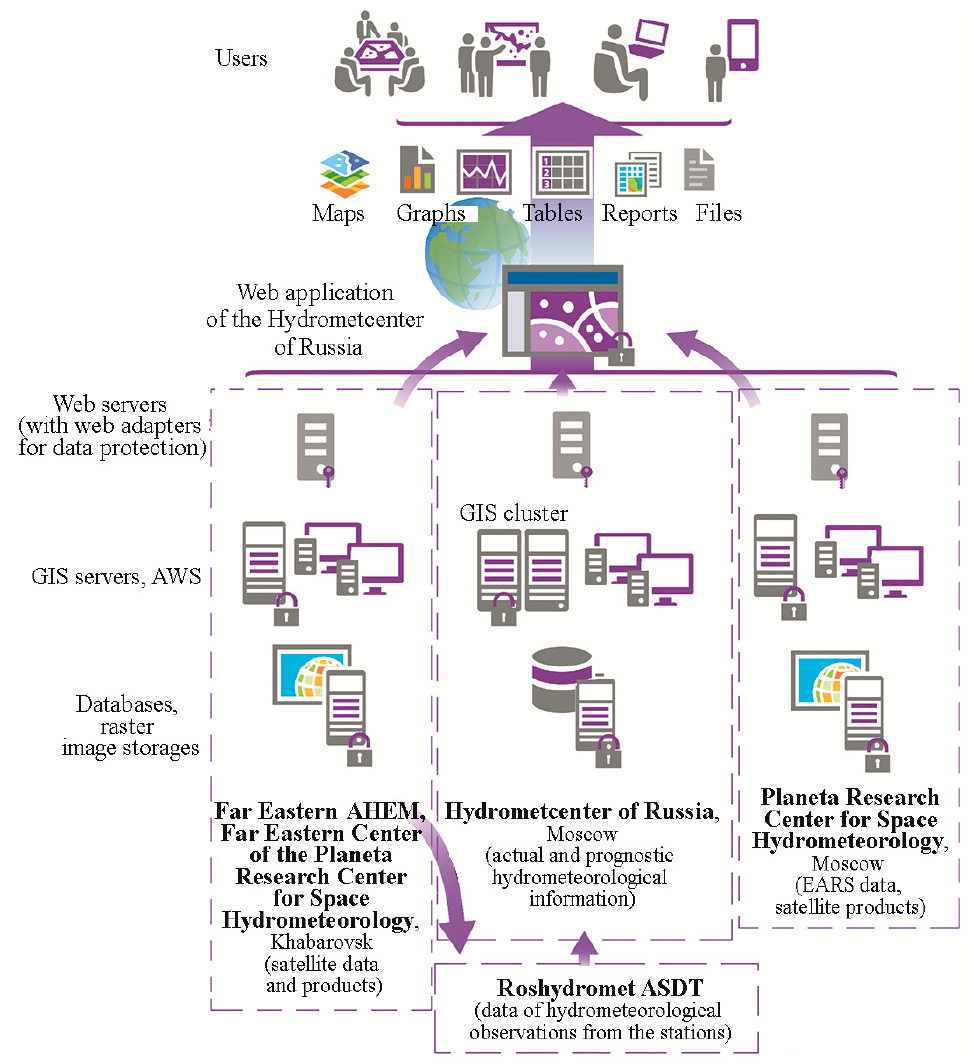
Figure 3. Architecture of the subsystem of preparation and delivery of flood forecasting and warning system output products to the end users (ASDT is automated system of data transmission).